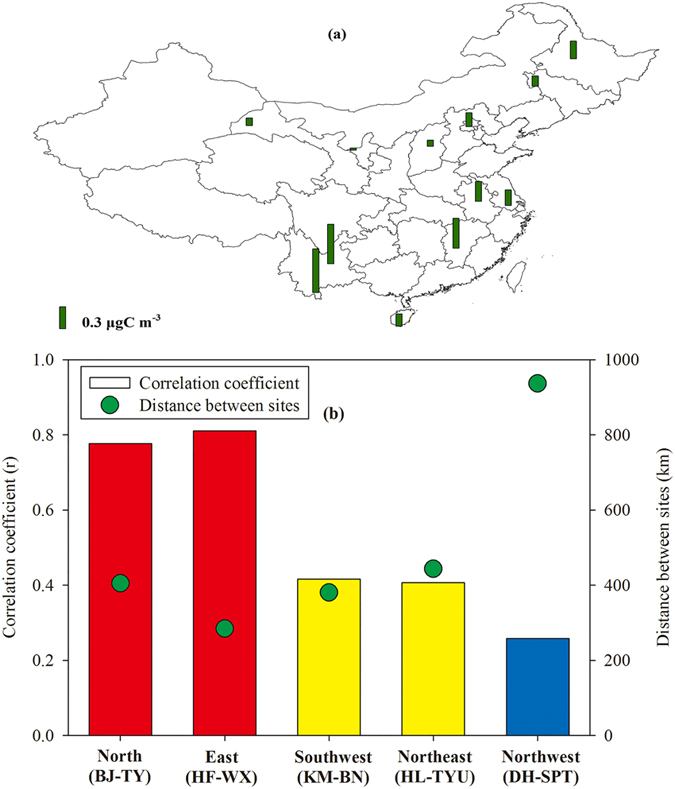
(a) Spatial distribution of SOCI in China (b) Correlation coefficient of SOCI between sites in each region. Red and yellow mean significant correlations at p < 0.01 and p < 0.05, respectively. Blue means poor correlation (p > 0.05). Figure 7a was created by ArcGIS 10.1.